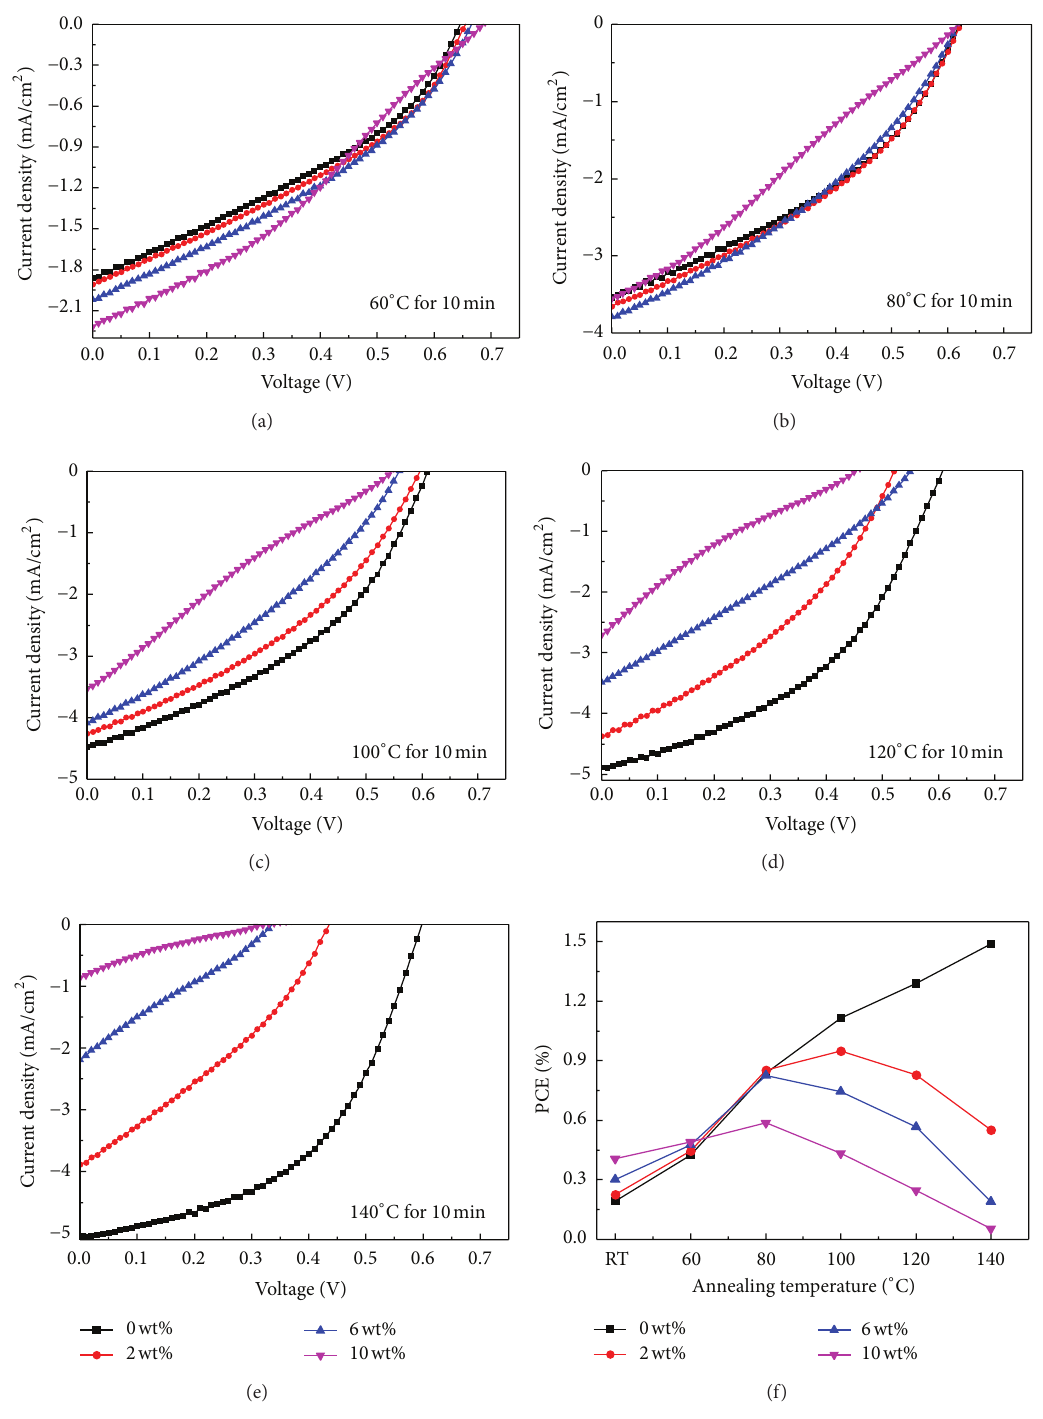
Figure 7: The 𝐽 - 𝑉 curves of PSCs under different annealing temperature and the relationship between PCE and annealing temperature.